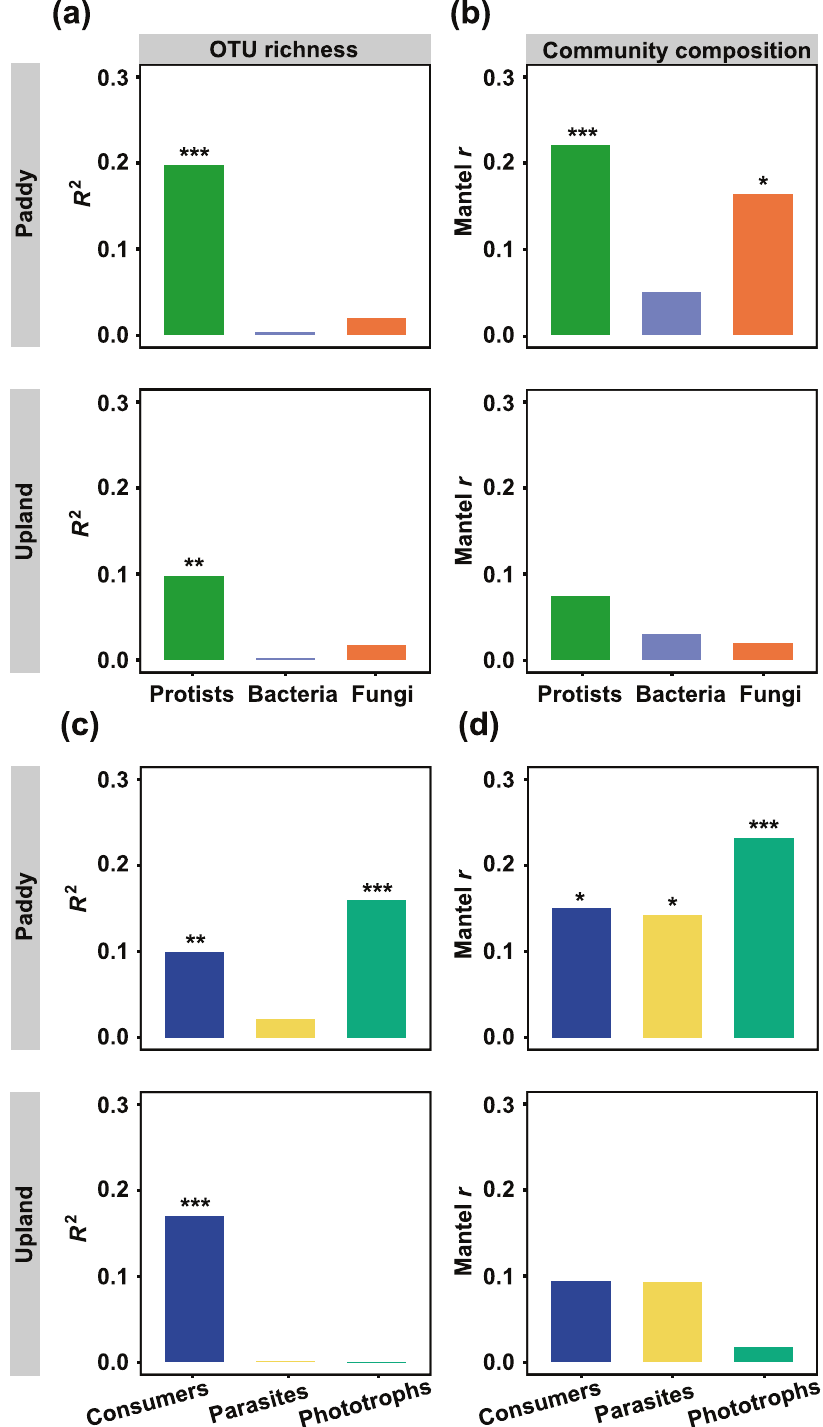
Fig. 1 Correlations between the diversity and community composition of protists, bacteria, fungi, and soil THg concentrations. The R 2 of Pearson ’ correlations re fl ect coef fi cients between the diversity of protists, bacteria, and fungi and soil THg concentrations ( a ). The Mantel statistic r re fl ects correlations between the community composition of protists, bacteria, and fungi and soil THg concentrations ( b ). The R 2 of Pearson ’ correlations re fl ect coef fi cients between the diversity of protistan trophic guilds and soil THg concentrations ( c ). The Mantel statistic r re fl ects correlations between the community composition of protistan trophic guilds and soil THg concentrations ( d ). The diversity index was calculated by OTU richness. The community composition was calculated by Bray – Curtis dissimilarity matrices. The columns with asterisks represent signi fi cant correlations (* P < 0.05, ** P < 0.01, *** P <